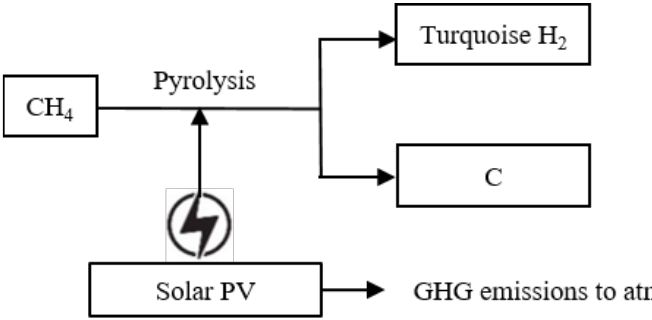
Figure 4. PFD of turquoise hydrogen with renewable energy (NG-RE).